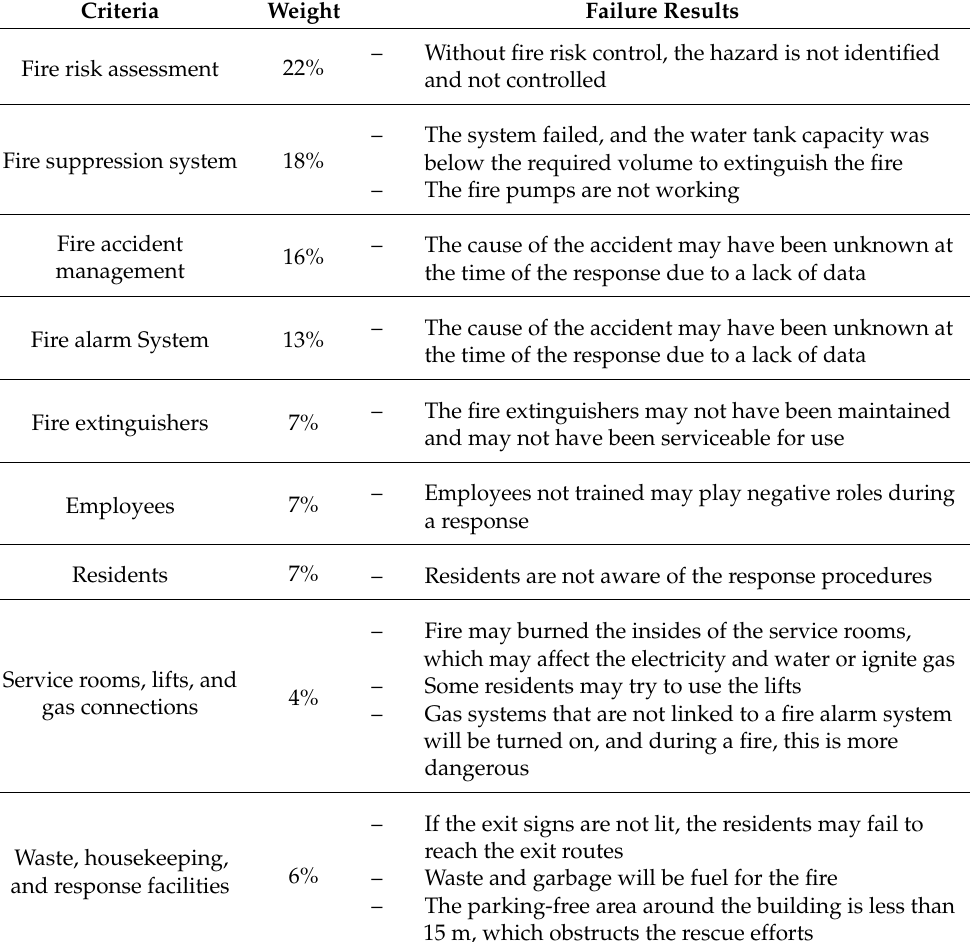
Table 5. HRBFI response failure results.